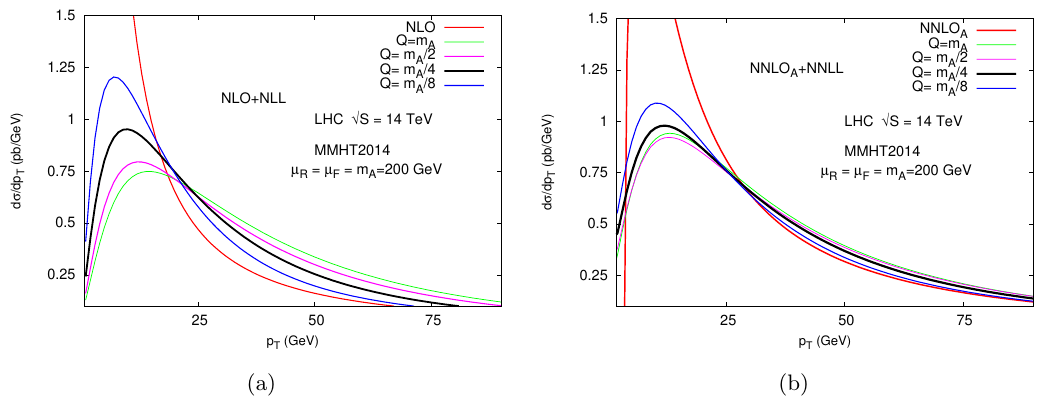
Figure 1 . Resummation scale variation for (a) NLO+NLL and (b) NNLO A +NNLL at 14